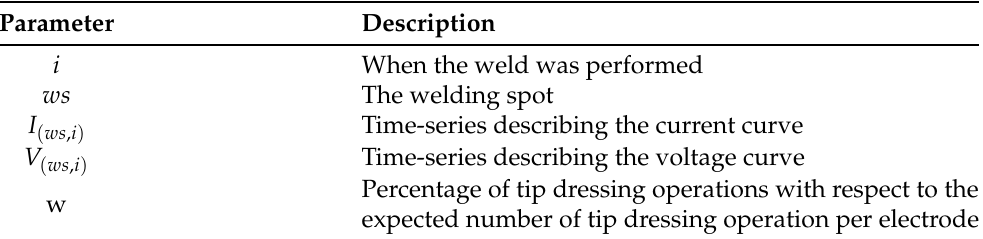
Table 1. Monitored